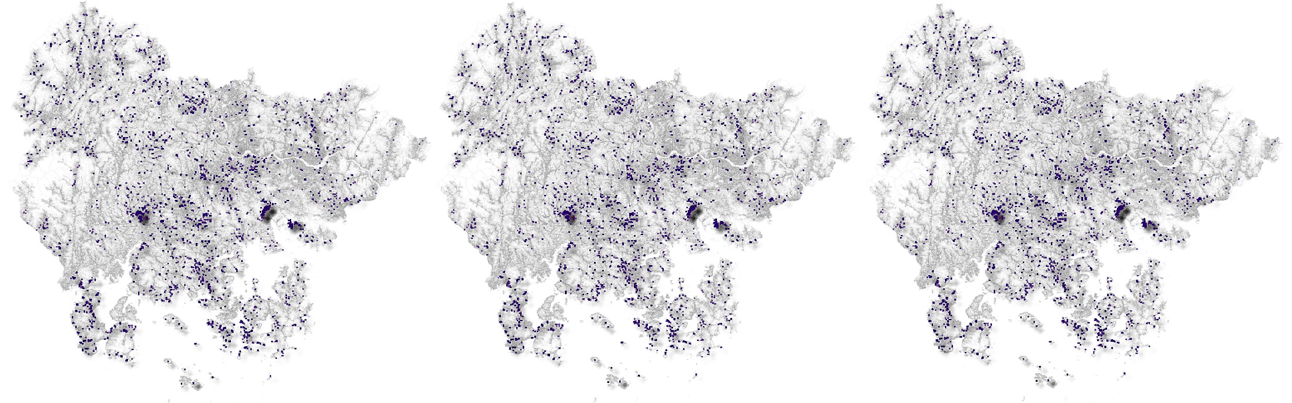
Figure 3. Locations of abandoned houses in submunicipal divisions in Gyeongsangnam-do (2017–2019).